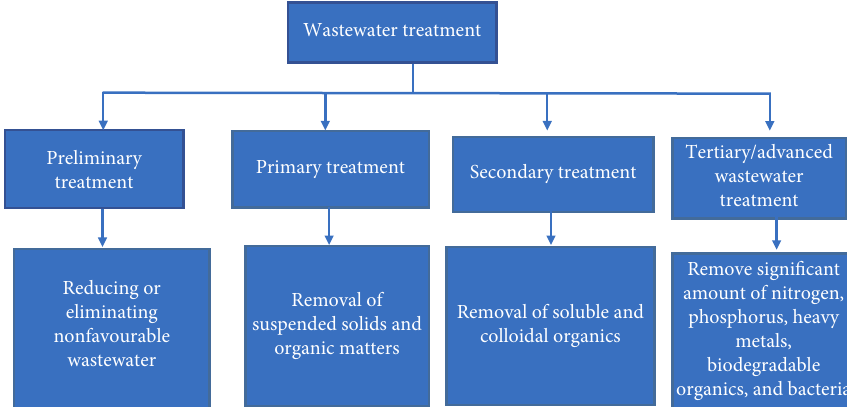
Figure 8: Various levels of wastewater treatment.